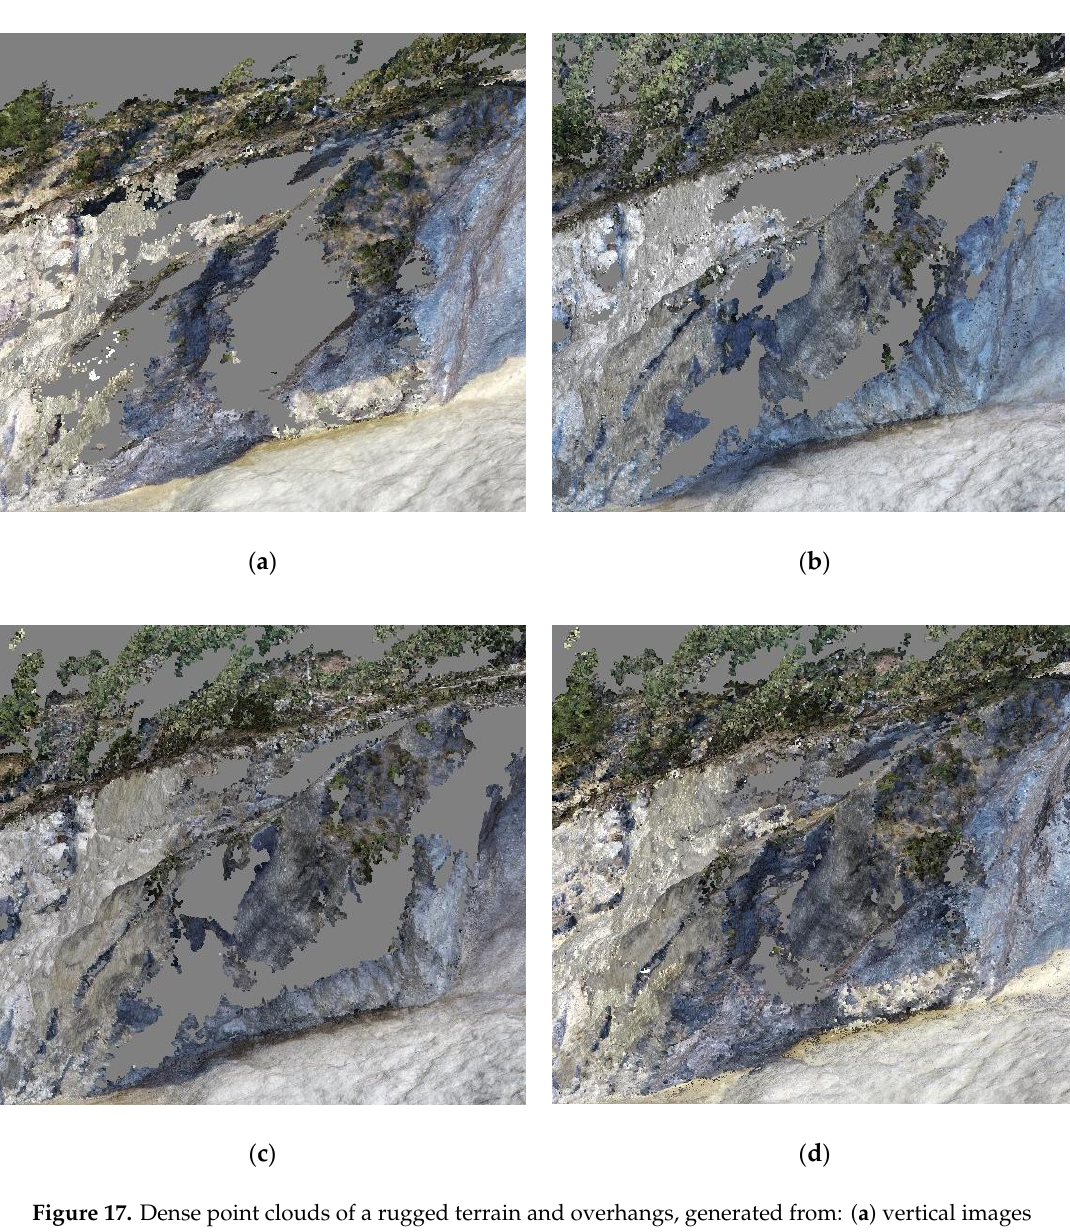
Figure 17. Dense point clouds of a rugged terrain and overhangs, generated from: ( a ) vertical images above NDTM; ( b ) oblique images above the fake DEM; ( c ) oblique images above the plane DEM and ( d ) merged dense point cloud from vertical and oblique images above the plane DEM.